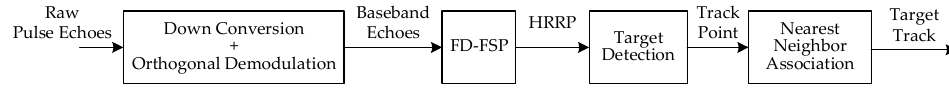
Figure 4. ( a , b ) Two typical HRRPs and the detected flight tracks by the high-resolution coherent VLR.